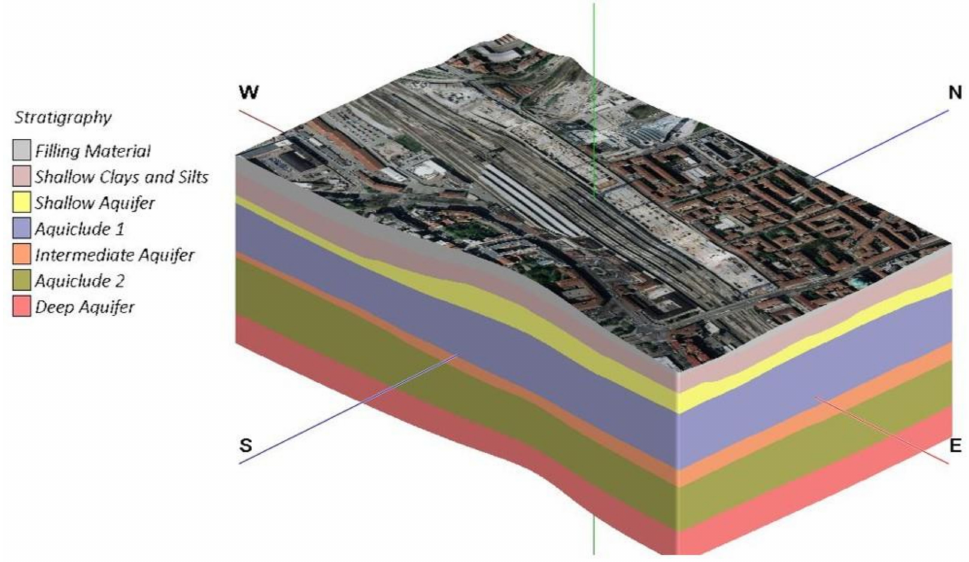
Figure 1. Three-dimensional geological model of the new high-speed railway station of